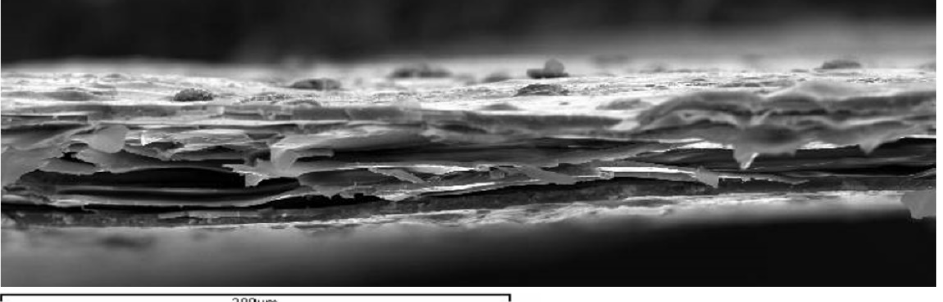
Figure 1. Image of a cross-section of the thin polypropylene films.